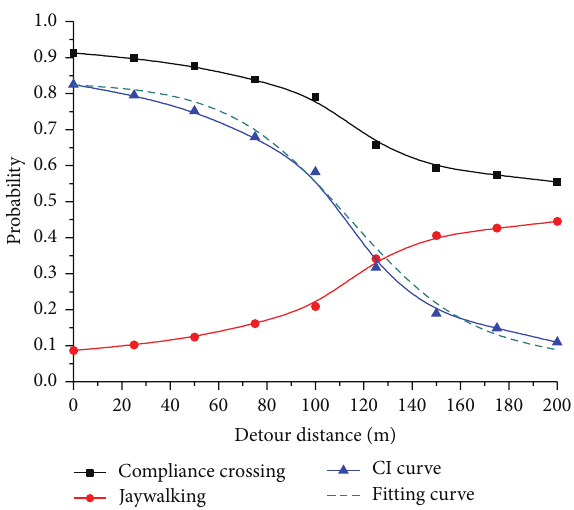
Figure 5: Illustration of compliance